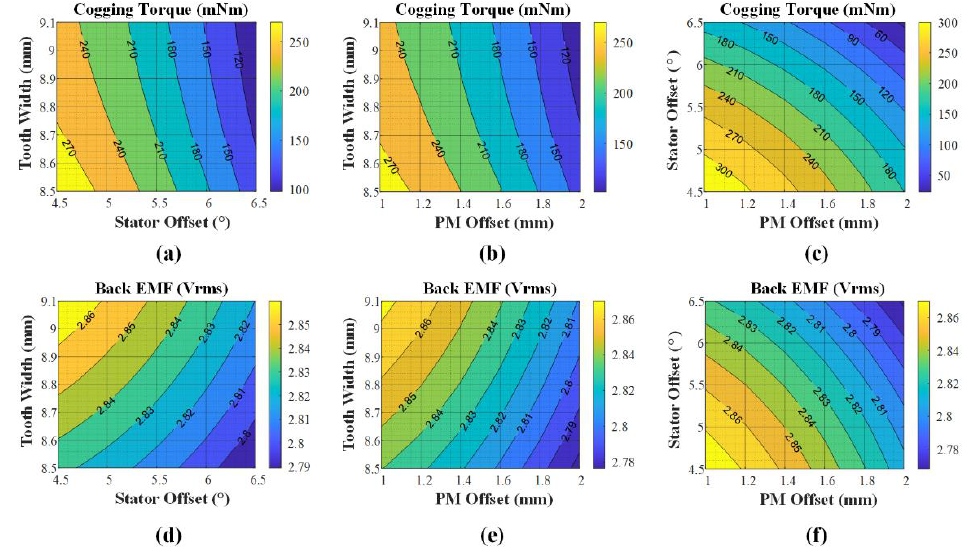
Figure 7. Contour plot of the cogging torque with ( a ) tooth width and stator offset, ( b ) tooth